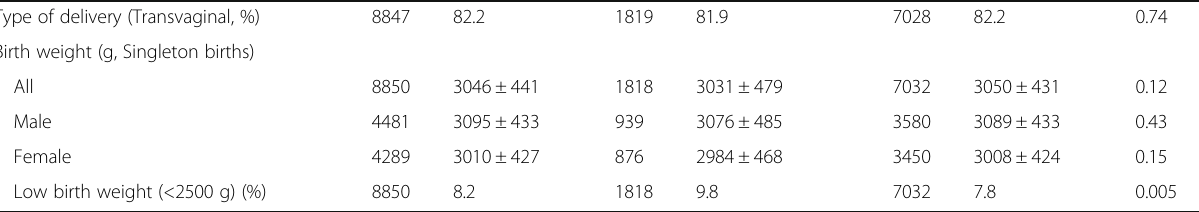
Table 1 Basic characteristics of the participants and the non-participants having live birth in the adjunct study of JECS (Continued) Type of delivery (Transvaginal, %)